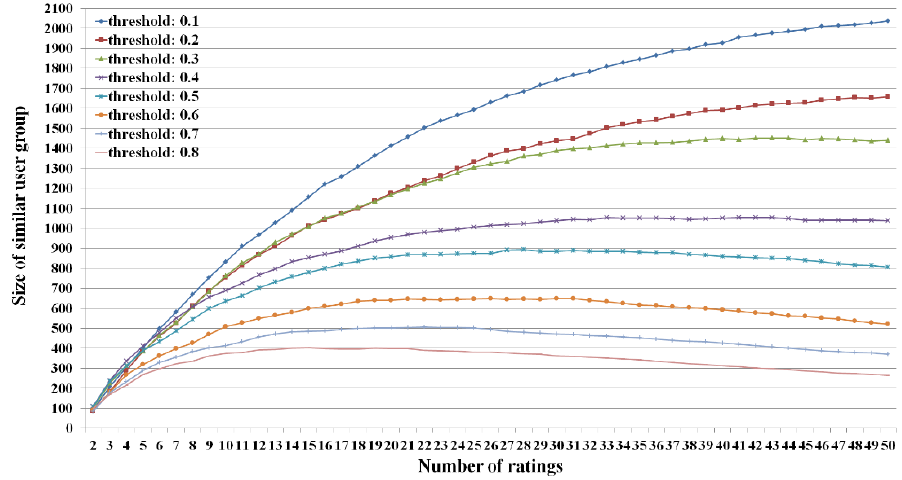
Figure 4. Size of similar user group according to the different numbers of ratings based on the Pearson correlation coefficient.